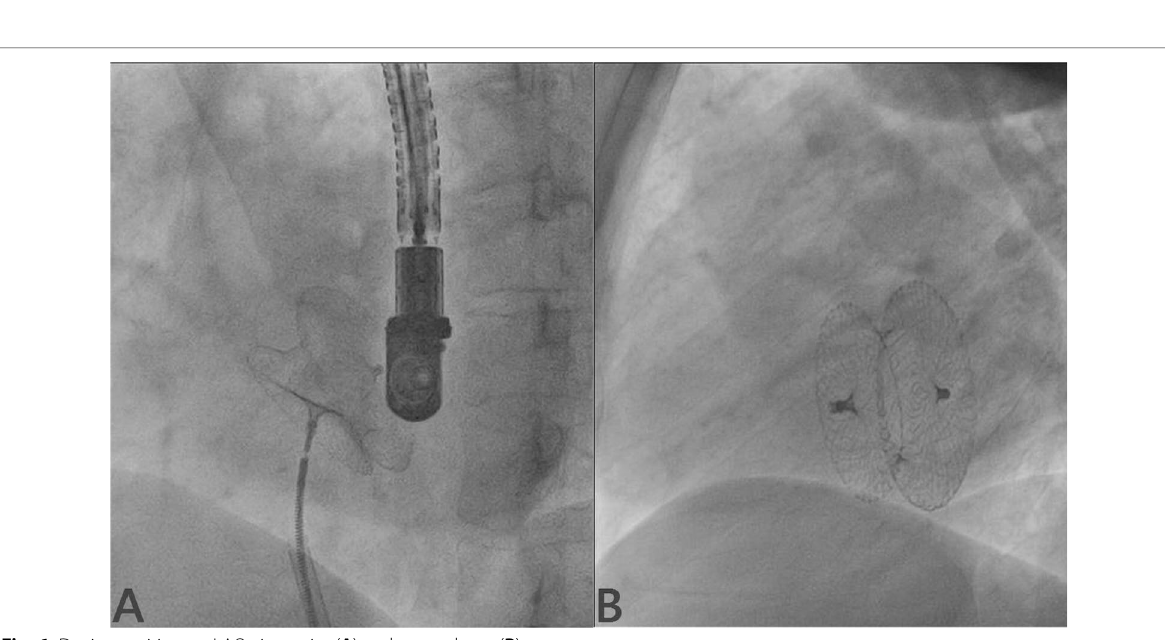
Fig. 6 Device position on LAO view prior ( A ) and post-release ( B